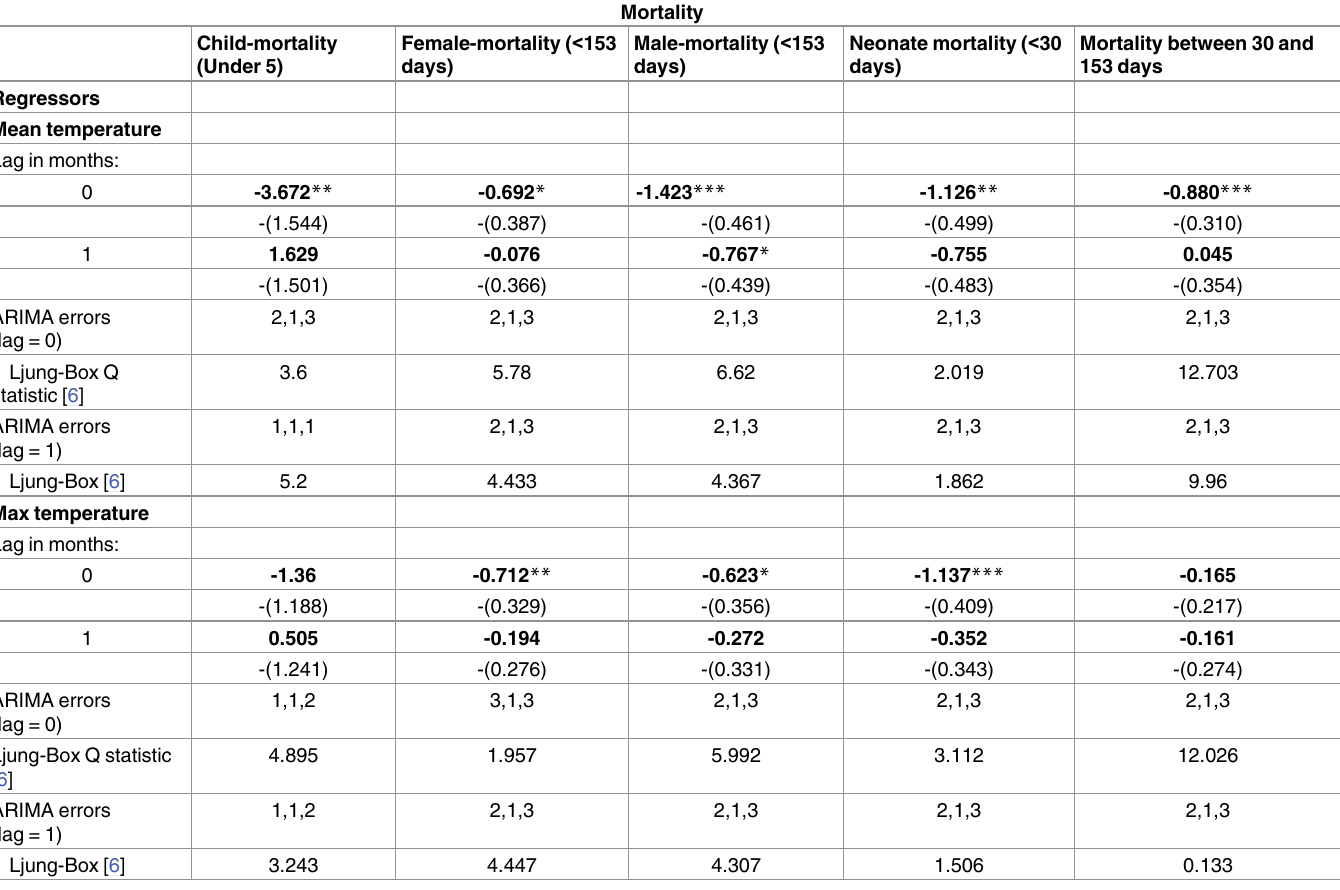
Table 2. Relationships between mortality (under 5, female and male < 153days,kids < = 30daysand kids > 30days) and monthly temperature (mean and maximum) over lags 0 to 1